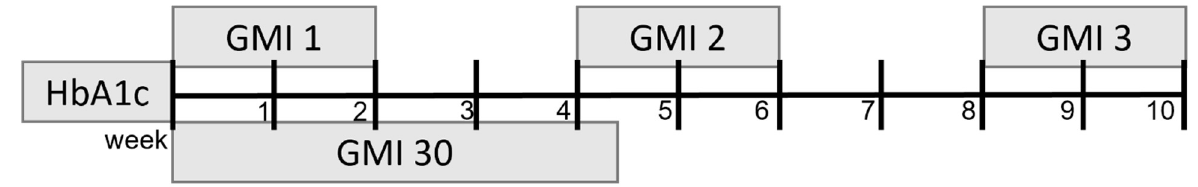
Figure 1. Timeline of GMI assessment in relation to HbA1c